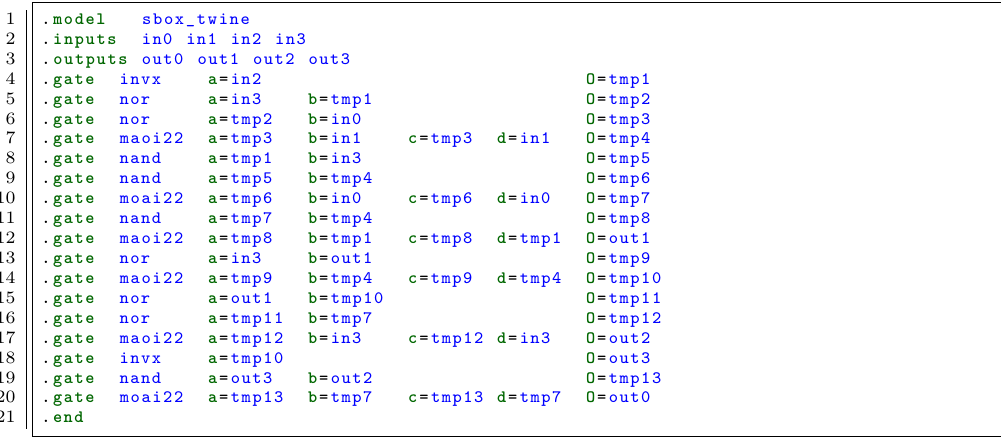
Figure 12: Area-optimized hardware implementation of TWINE Sbox using 25 GE with the standard cell library of the TSMC 65nm logic